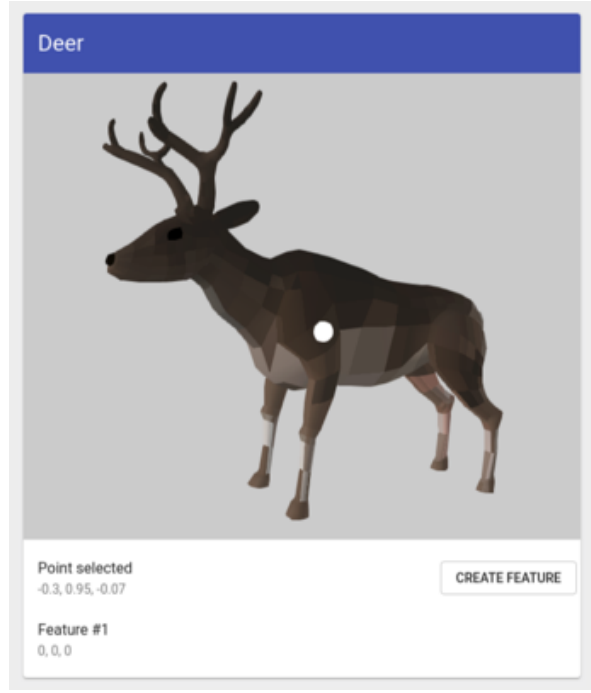
Figure 7. Prompting and point selection of a X3D data from our